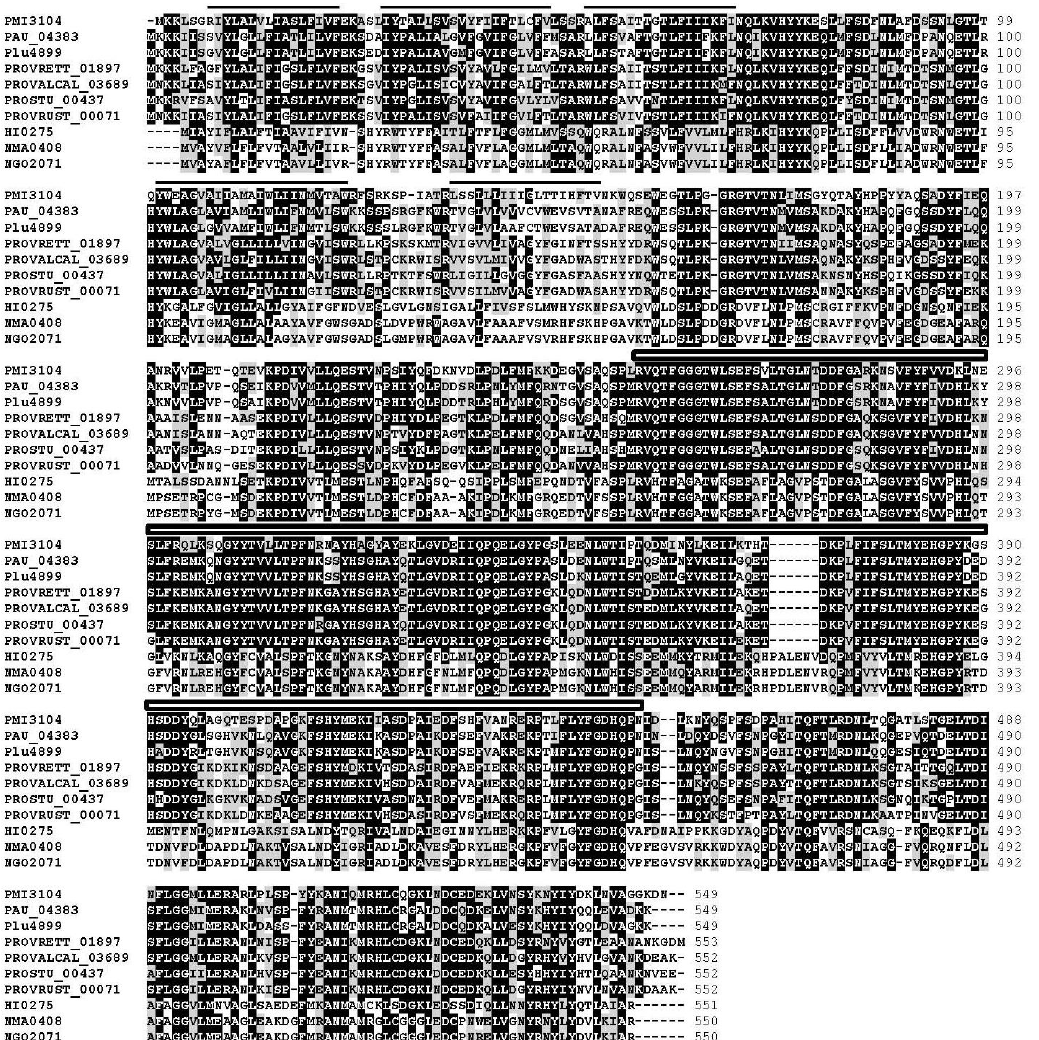
Figure 3. Amino acid alignment among known and putative proteins responsible for the transfer of PEtN to the O -6 of L , D -HepII. P. mirabilis PMI3104 (EptC), Photorhabdus asymbiotica asymbiotica ATCC 43949 (PAU_04383), Pho. luminescnes laumondii TT01 (Plu4899), Providencia rettgeri DSM 1131 (PROVRETT_01897), Prov. alcalifaciens DSM 30120 (PROVALCAL_03689), Prov. stuartii ATCC 25827 (PROSTU_00437), Prov. rustigianii DSM 4541 (PROVRUST_00071), Haemophilus influenzae Rd KW20 (HI0275), Neisseria meningitidis Z2491 (NMA0408), and N. gonorrhoeae FA 1090 (NGO2071). Black lines denote putative transmembrane regions and the box denotes amino acid residues similar to the sulfatase domain in PMI3104 (EptC). Numbers indicated the GenBank protein sequences; Identical amino acids are shown on a black background; and similar residues are shown on a gray